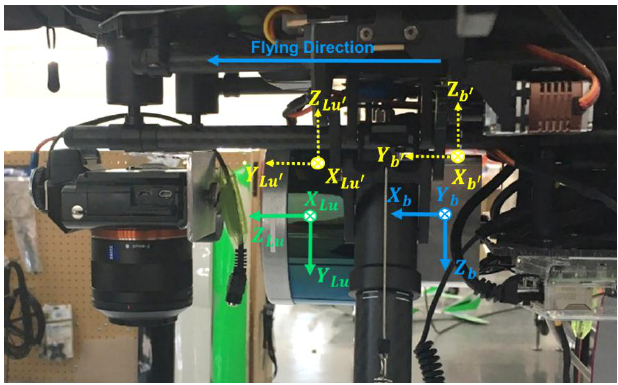
Figure 10. Actual alignment of coordinate systems for the UAV LiDAR system used in this study.